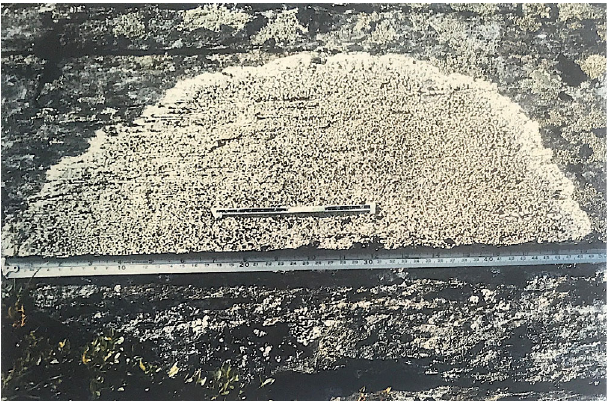
Figure 5. Giant Rhizocarpon alpicola of 493 mm diameter of unknown age measured in 1984 on Mt Nuolja above Abisko in Sweden [15].